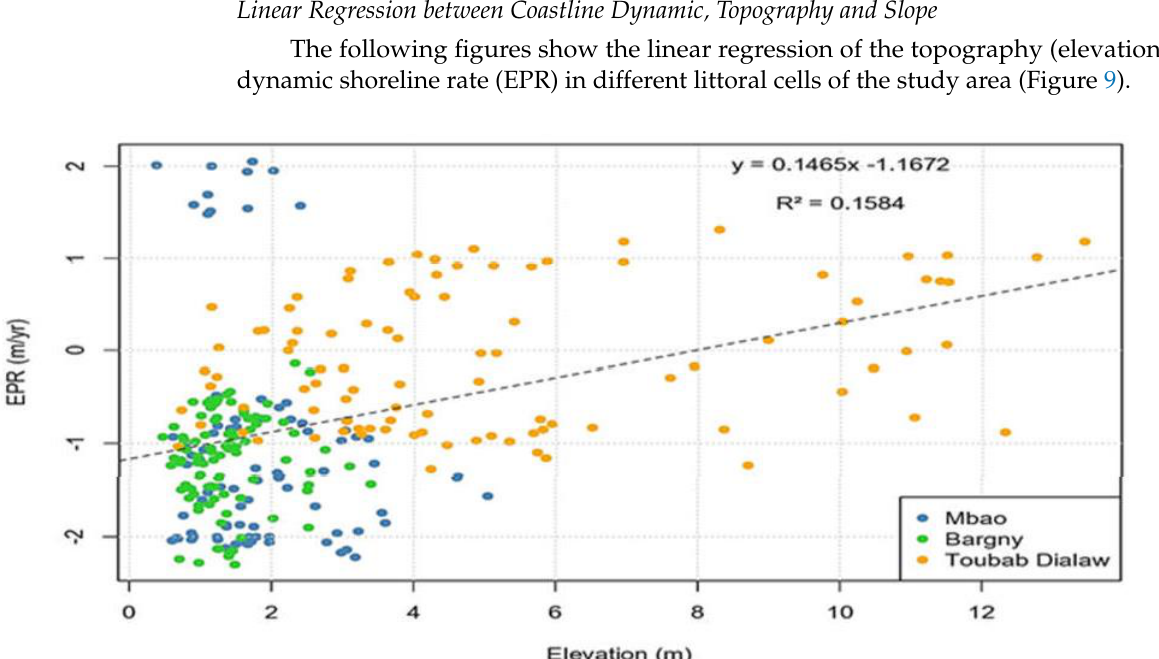
Figure 10. Cross plot of the shoreline change rate and slope in the three littoral cells. The following figure is the box plot of the topography, slope and coastline dynamic rate (EPR) in the three littoral cells. It helps to understand the distributional characteristics of the topography, slope and coastline dynamic value in each littoral cell. For the topo- graphy, the upper quartiles in Mbao and Bargny are lower than 2.5 m, whereas in Toubab Dialaw, 50% of the observed values exceed 4 m. In terms of slope, all quartiles are lower